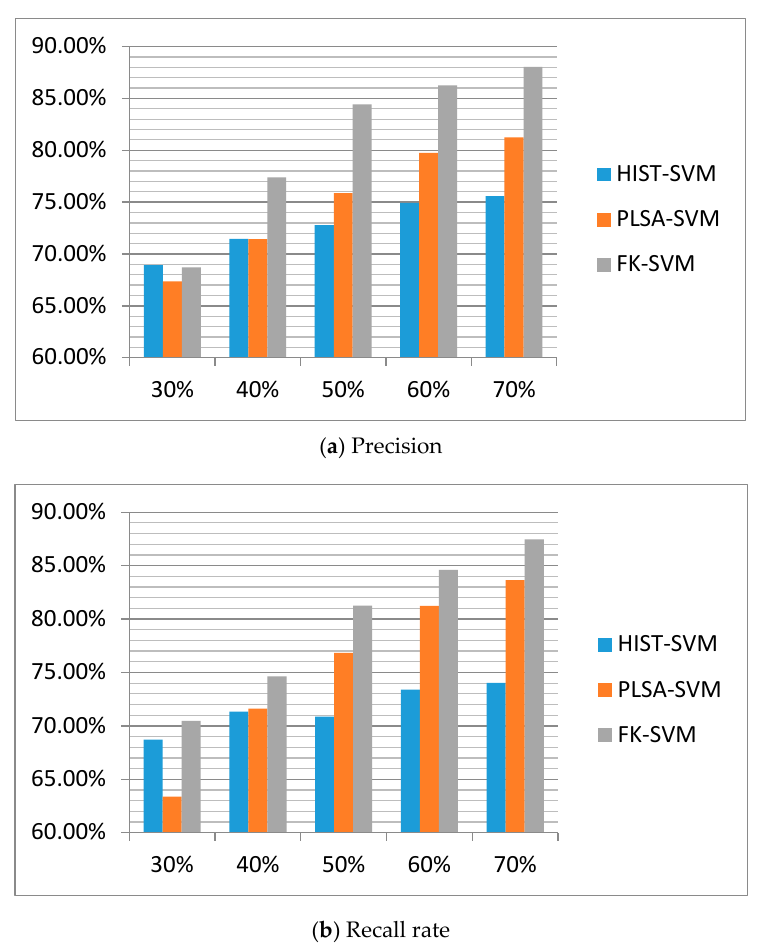
Table 2 and Figure 3 present the experimental results of the algorithm, respectively.